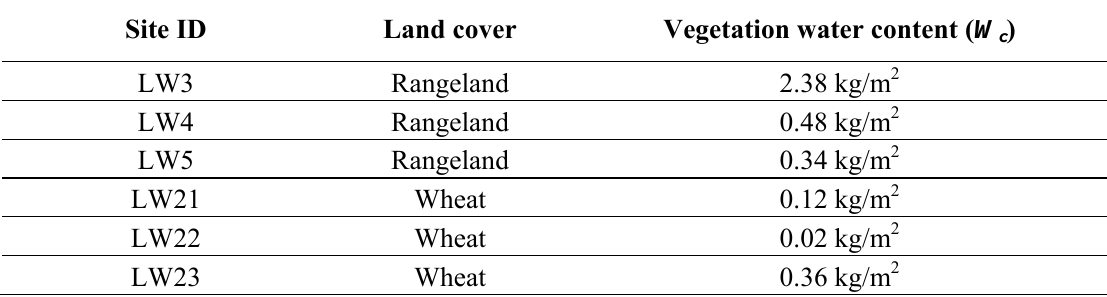
Table 5. Land cover type and vegetation water content at each site from